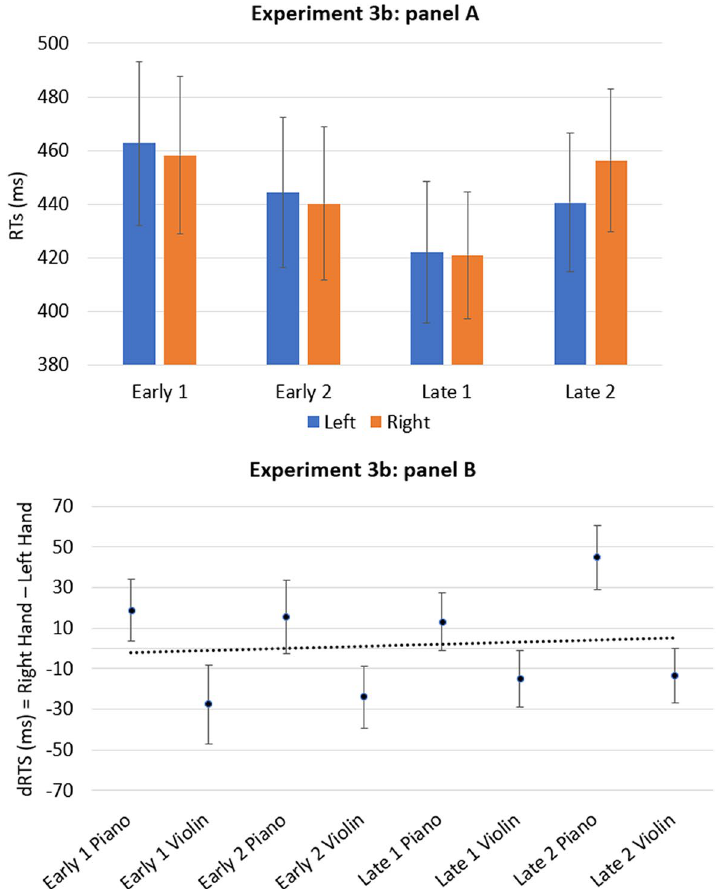
Figure 4. The panel ( A ) shows the mean of response times of the left and right hands for the four onset timing of the target (early 1, early 2, late 1, late 2). The panel ( B ) shows the mean dRTs (right key–left key) for each condition of the target. Positive differences indicate faster left-key responses; negative differences indicate faster right-key responses. Errors bars indicate standard error of the